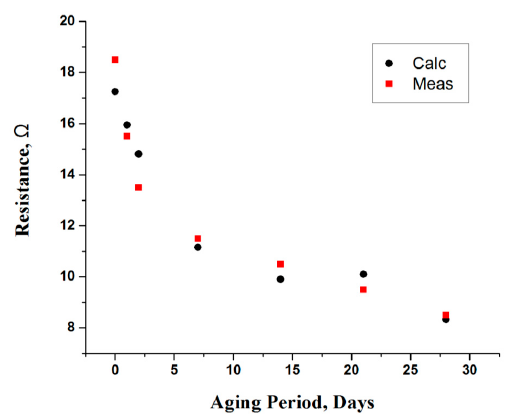
Figure 10. Resistance (R 1 ) of an intracellular fluid (ICF) as a function of aging period.